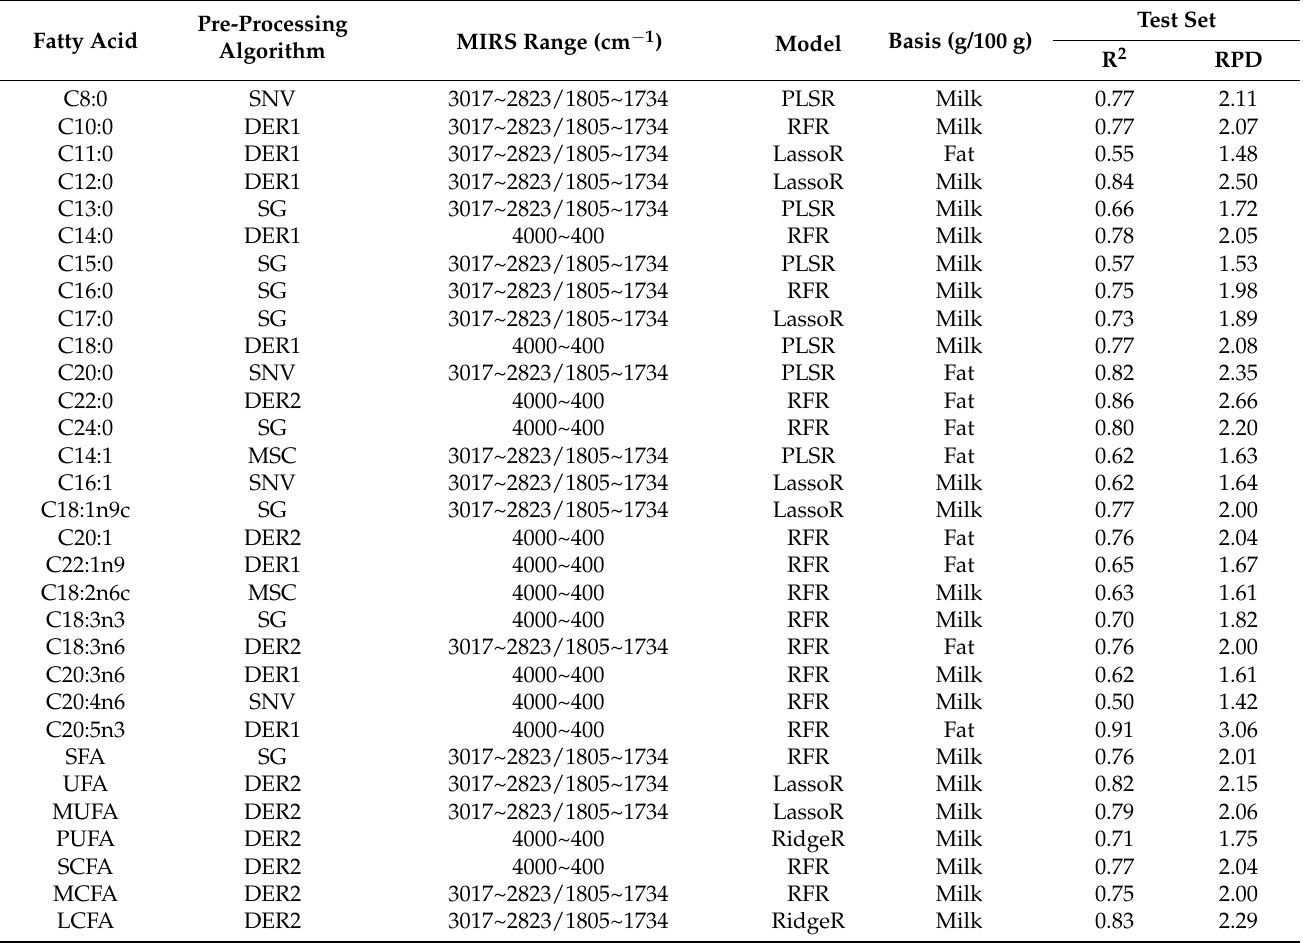
Table 2. Best prediction accuracy for the optimal strategy in the test set for each fatty